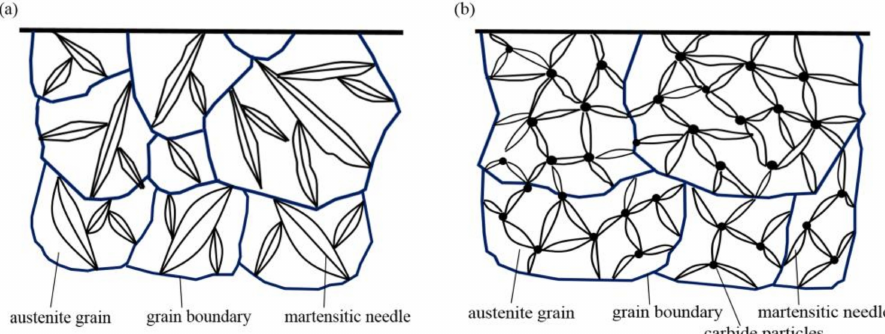
Figure 17. Transformation models of martensite in the grain interior for ( a ) conventional carburization and the ( b ) RE carburization